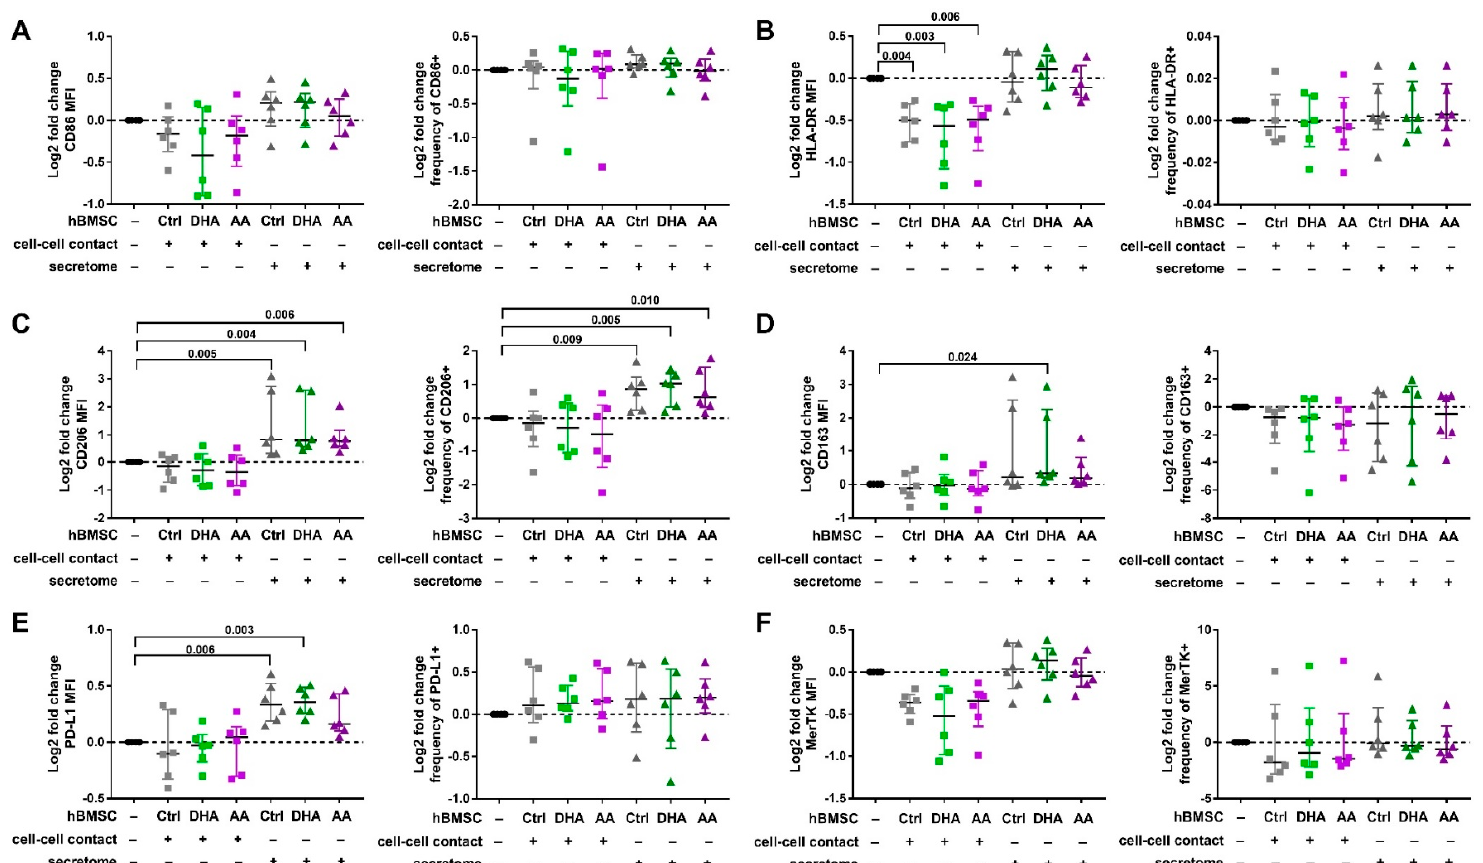
Figure 2. The effect of hBMSC cell-cell contact and secretome on the cell surface the phenotype of Mreg-polarized macrophages. The median fluorescence intensities (MFI, on the left in each panel) and frequencies of positive cells (on the right in each panel) were determined with flow cytometry investigating the expression of ( A ) CD86, ( B ) HLA-DR, ( C ) CD206, ( D ) CD163, ( E ) PD-L1 and ( F ) MerTK. The effect of hBMSCs is visualized with log2 fold changes calculated against macrophages cultured without hBMSCs (represented by the zero line) for each individual donor. The differences among groups were determined with Kruskal-Wallis rank sum test and post hoc using Dunn’s test (the latter presented in the figures). The results are expressed as log2 fold changes as medians with interquartile ranges; n = 6 biological replicates. Ctrl, control; DHA, docosahexaenoic acid; AA, arachidonic acid.